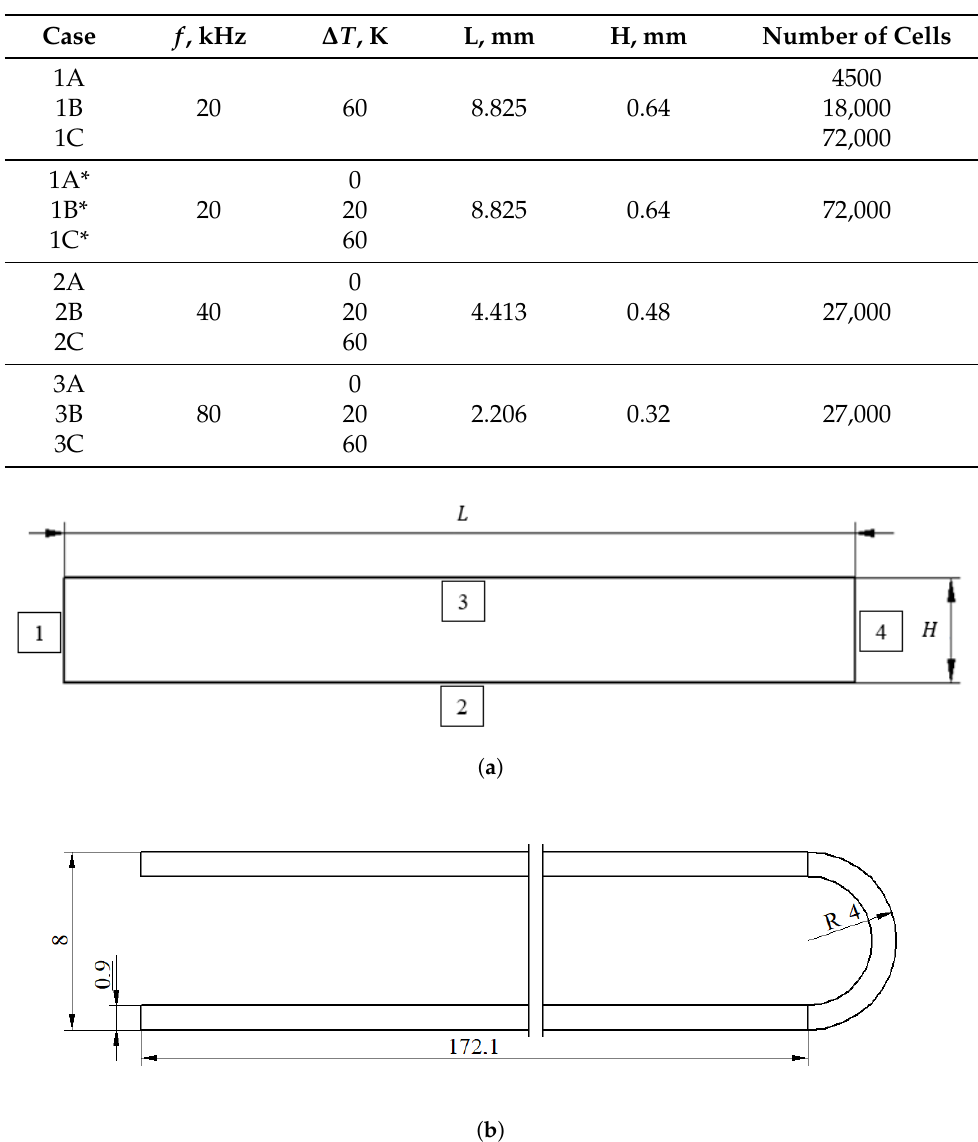
Table 1. Mesh independence study and investigated cases.